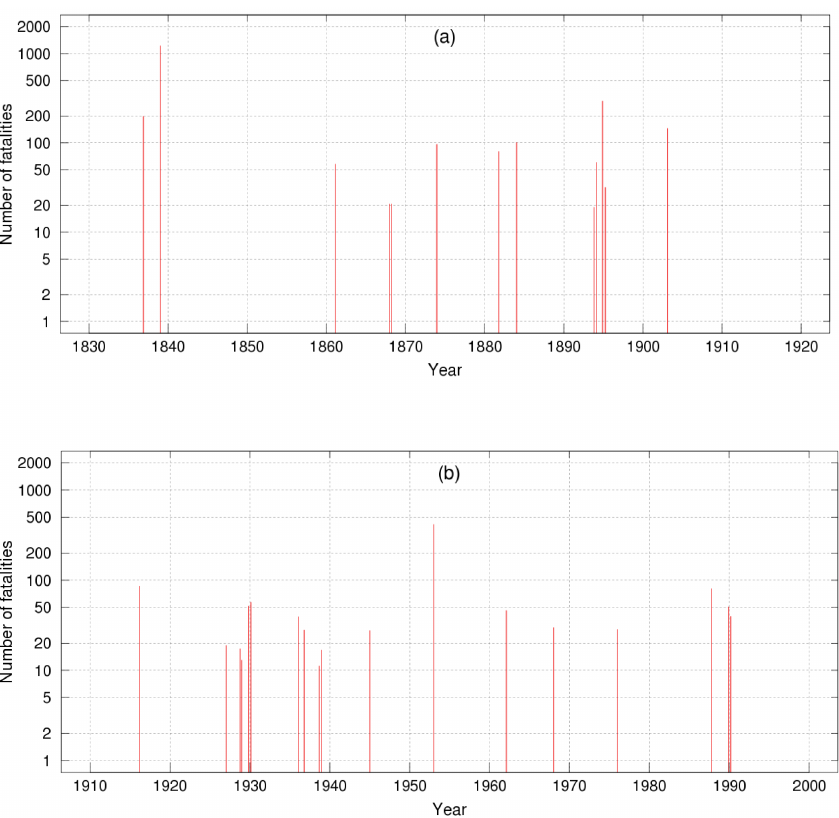
Figure 1. Time series of storm fatalities in the UK from the UK-RMS-160 data set. All data are adjusted as if the storms had occurred during daytime and trended to 1994 population levels.